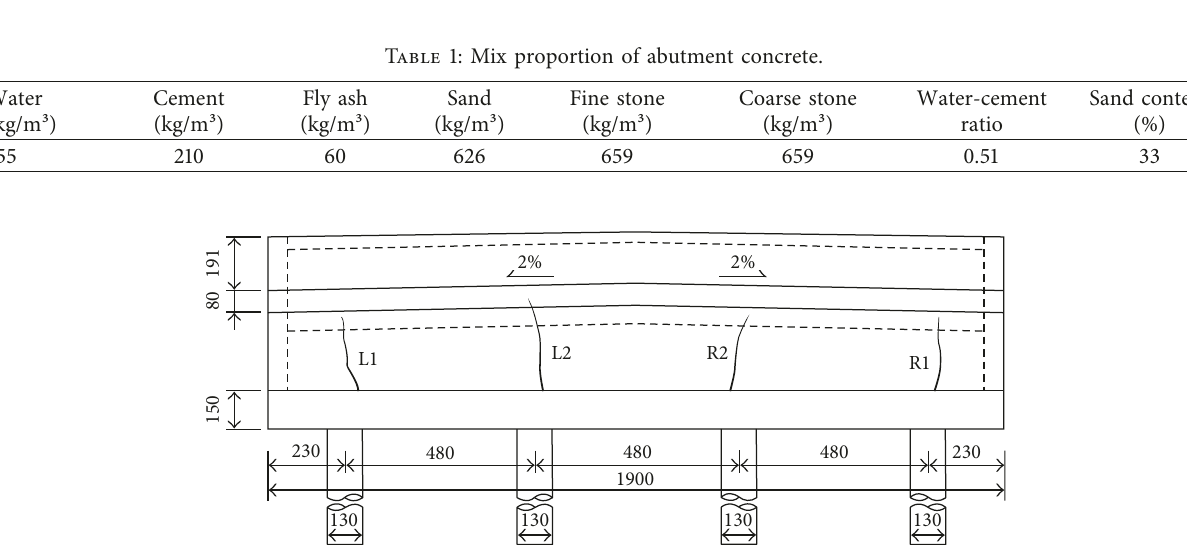
Figure 2: Crack distribution on the subject abutment (cm).